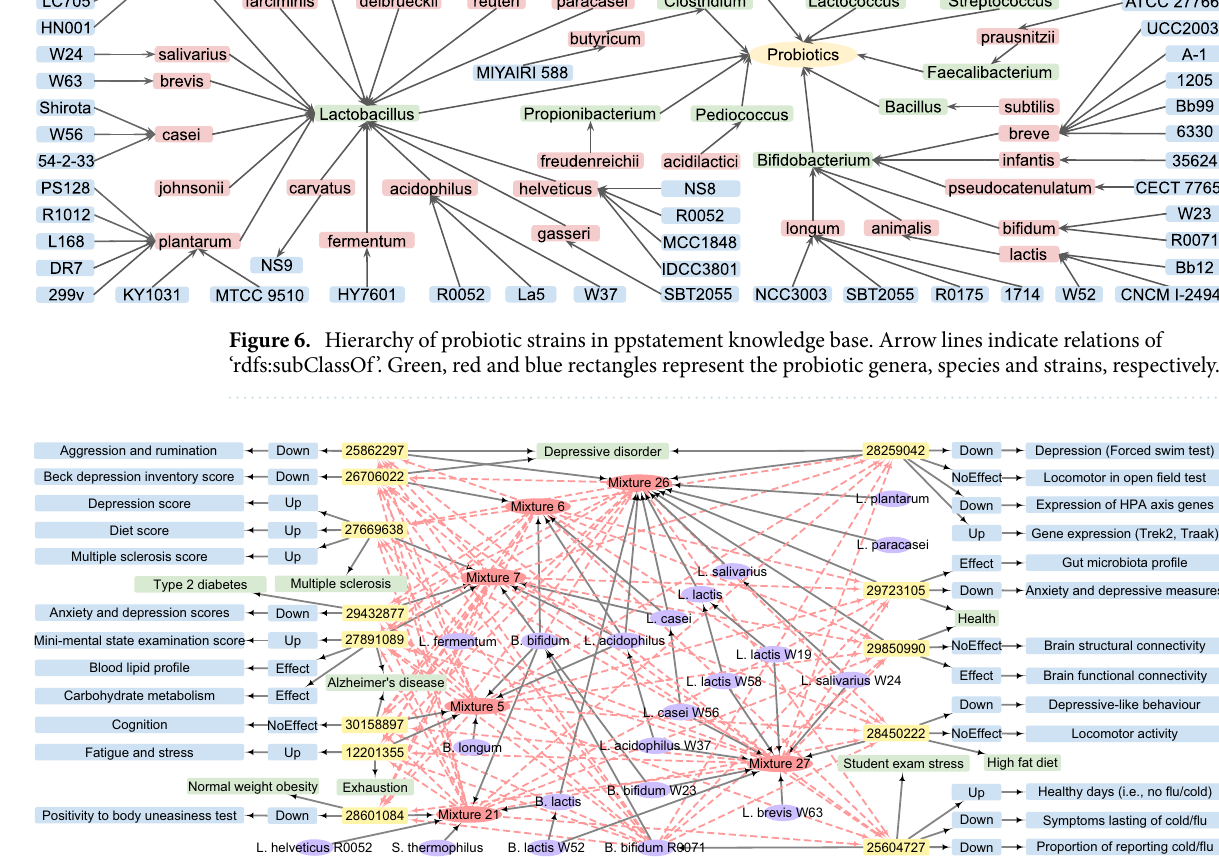
Figure 7. The returned results of B. bifidum strains’ effects on diseases by query case 1, with the code shown in SI Listing 1. Yellow rectangles: PMIDs; green rectangles: populations; red ellipses: probiotic mixtures; purple ellipses: probiotic strains; blue rectangles: treatment effects; solid black lines: direct relations; red dotted lines: indirect relations between